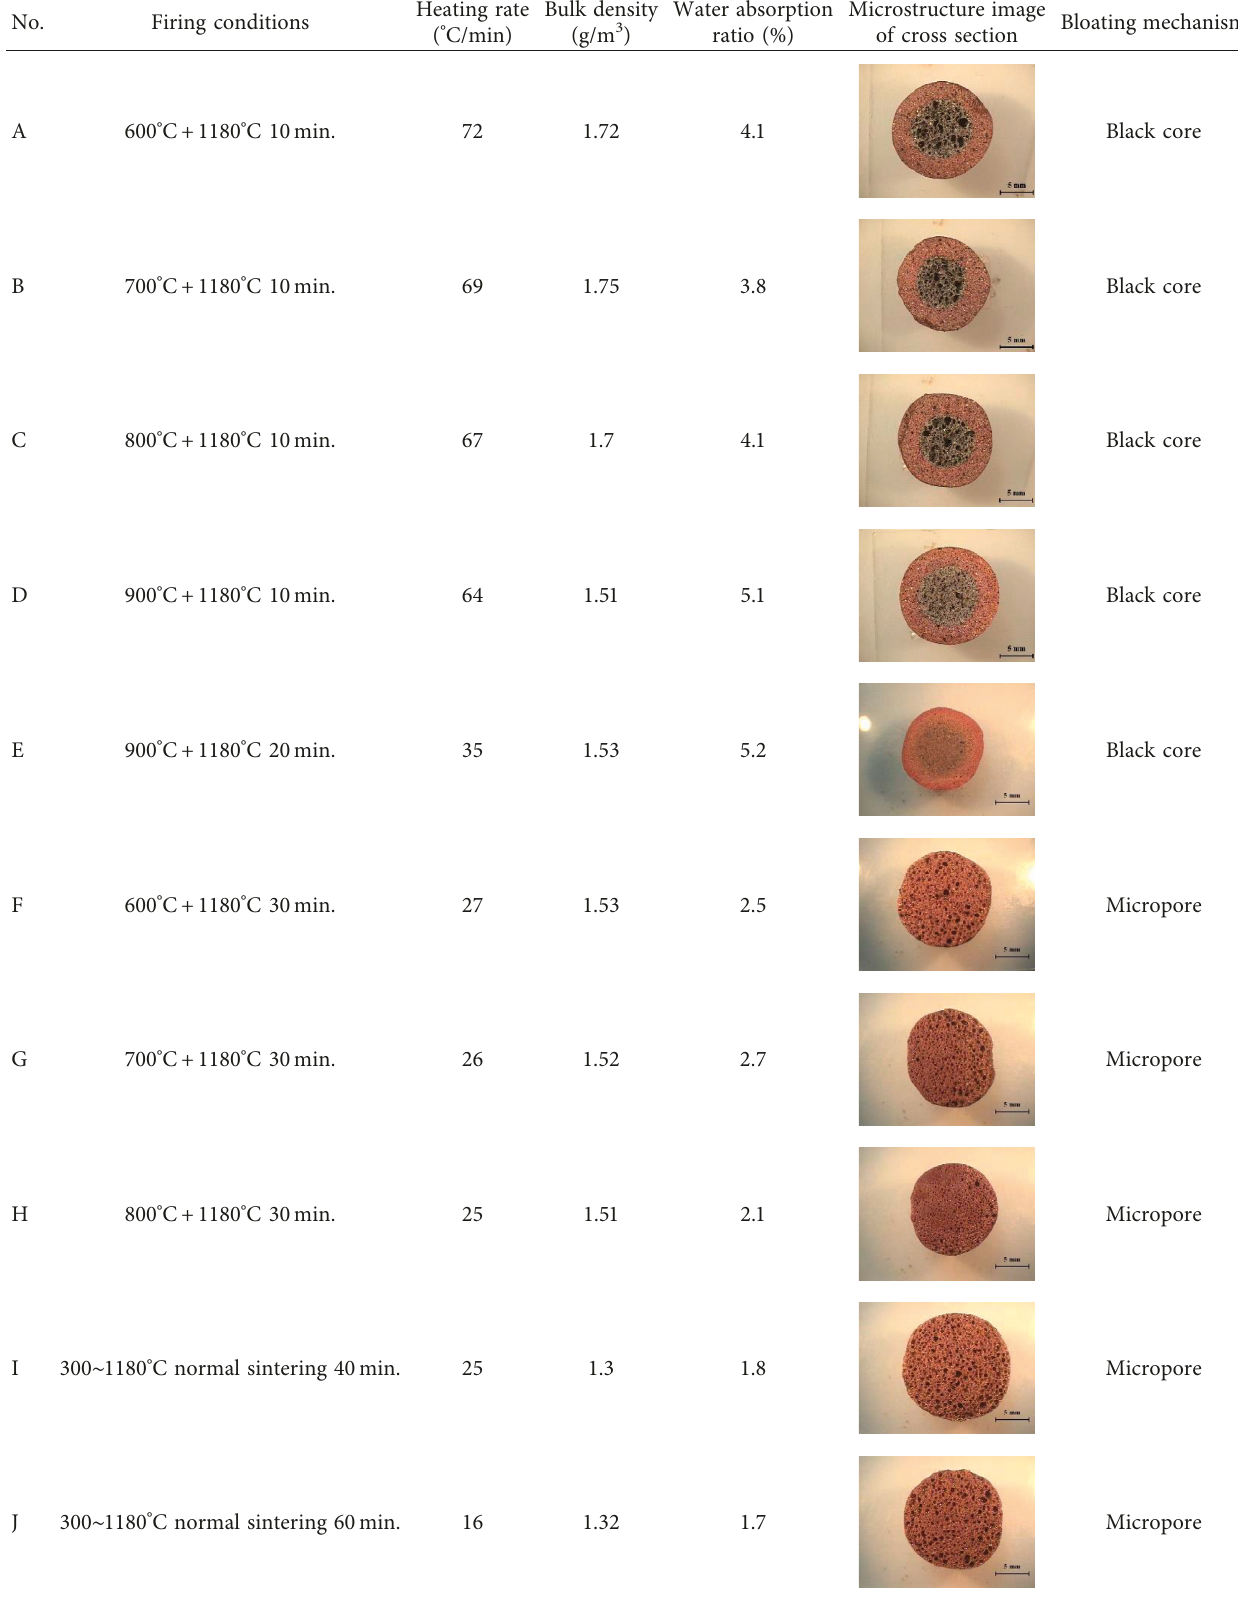
Table 4: Bulk density and microstructure with ramping